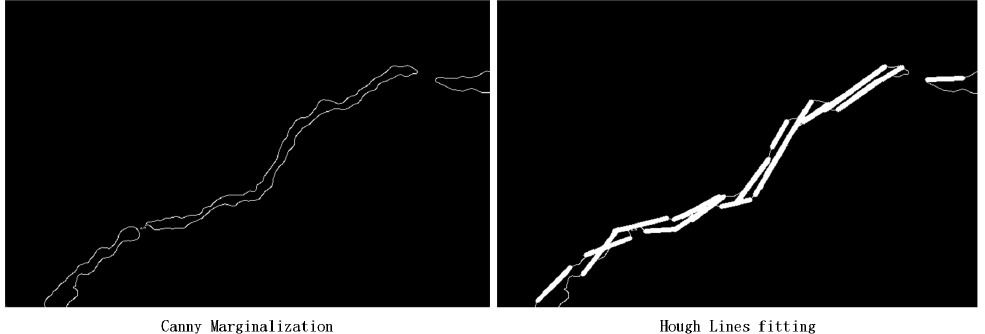
Figure 11. Schematic diagram of non-maximum suppression.